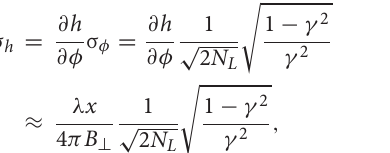
Frontiers in Earth Science |